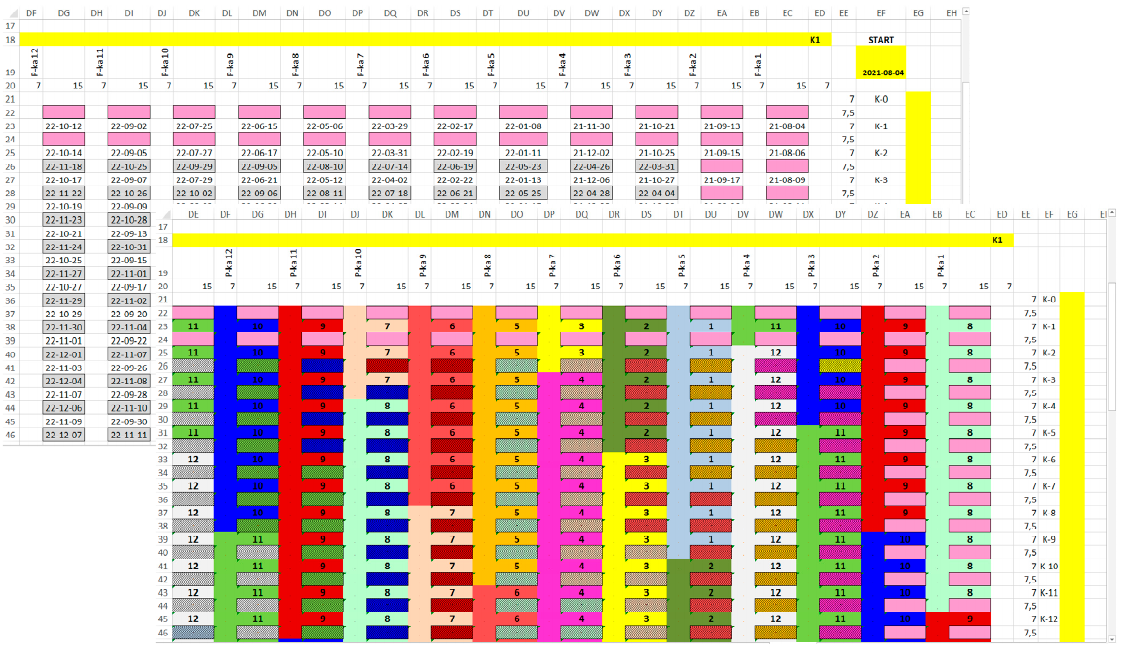
Figure 7. Planned schedule of mining works in the room and pillar mining system.